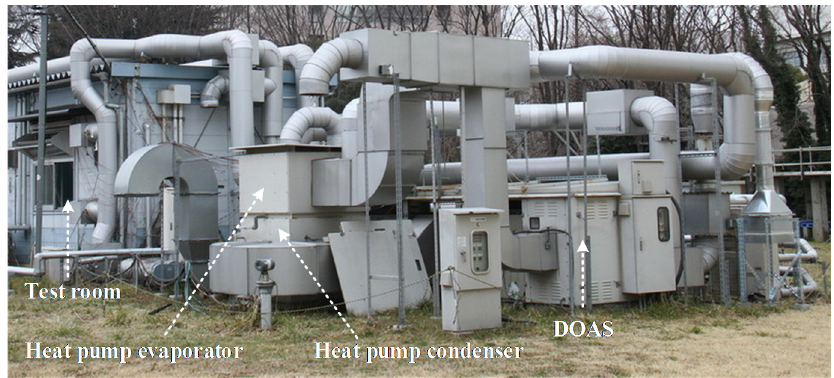
Figure 1. Appearance of the experimental setup.